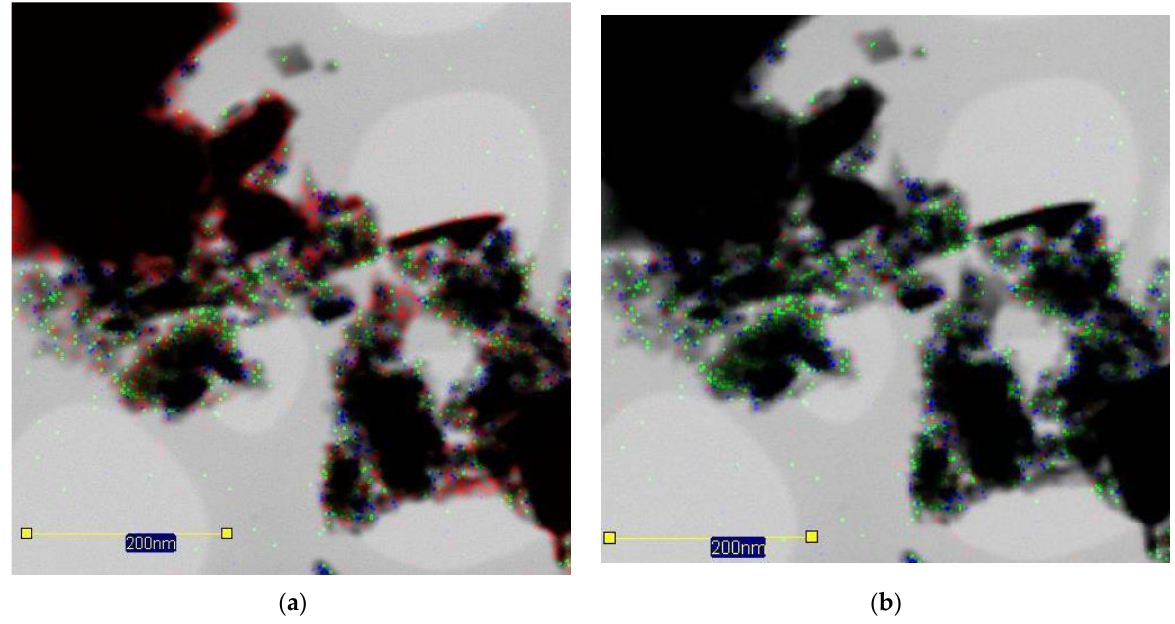
Figure 9. ( a ) Reconstructed 2D maps of EDXS of fines of original Skye sand (Si: red, Al: blue and Fe: green); ( b ) reconstructed 2D maps of EDXS fines of arsenic-treated Skye sand (As: red, Al: blue and Fe: green).